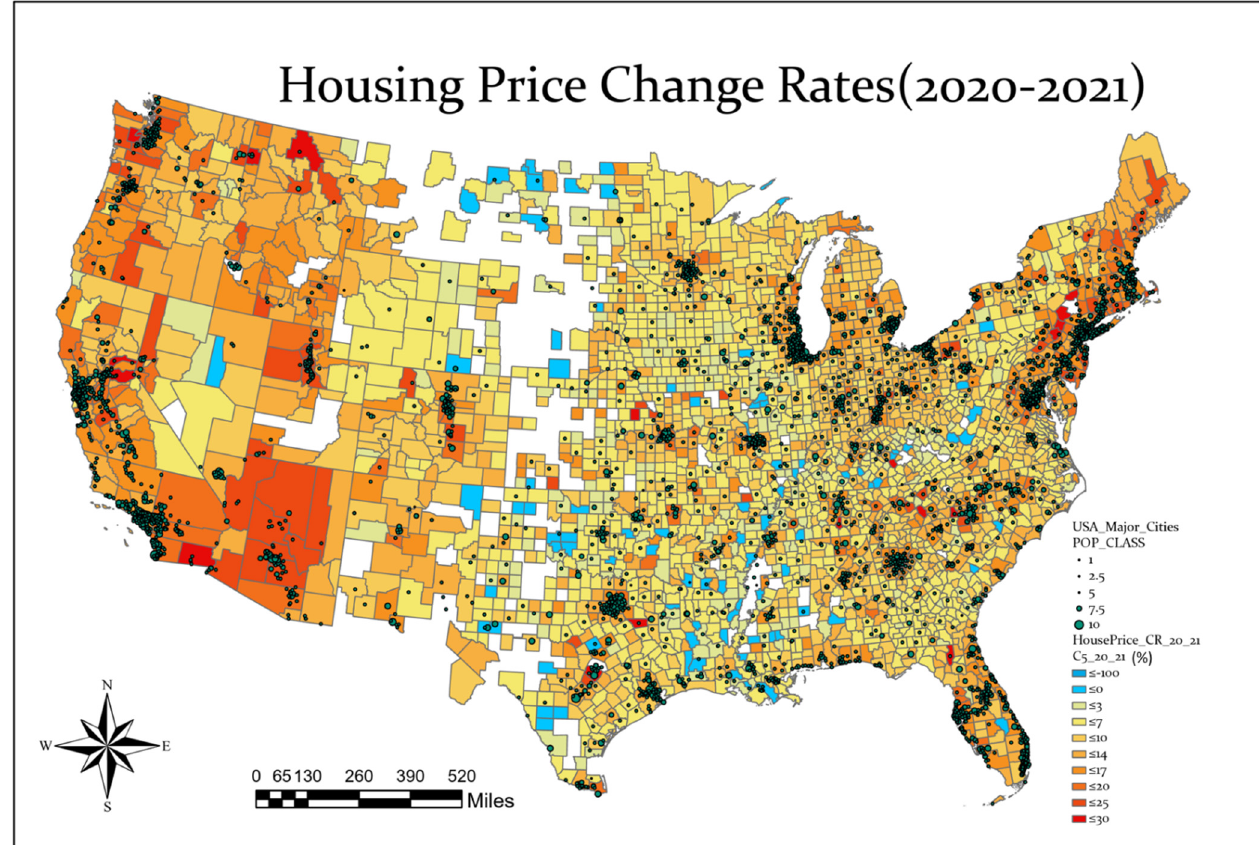
Figure 5. Overlay of cities with housing price change rates during the pandemic year of 2020–2021.